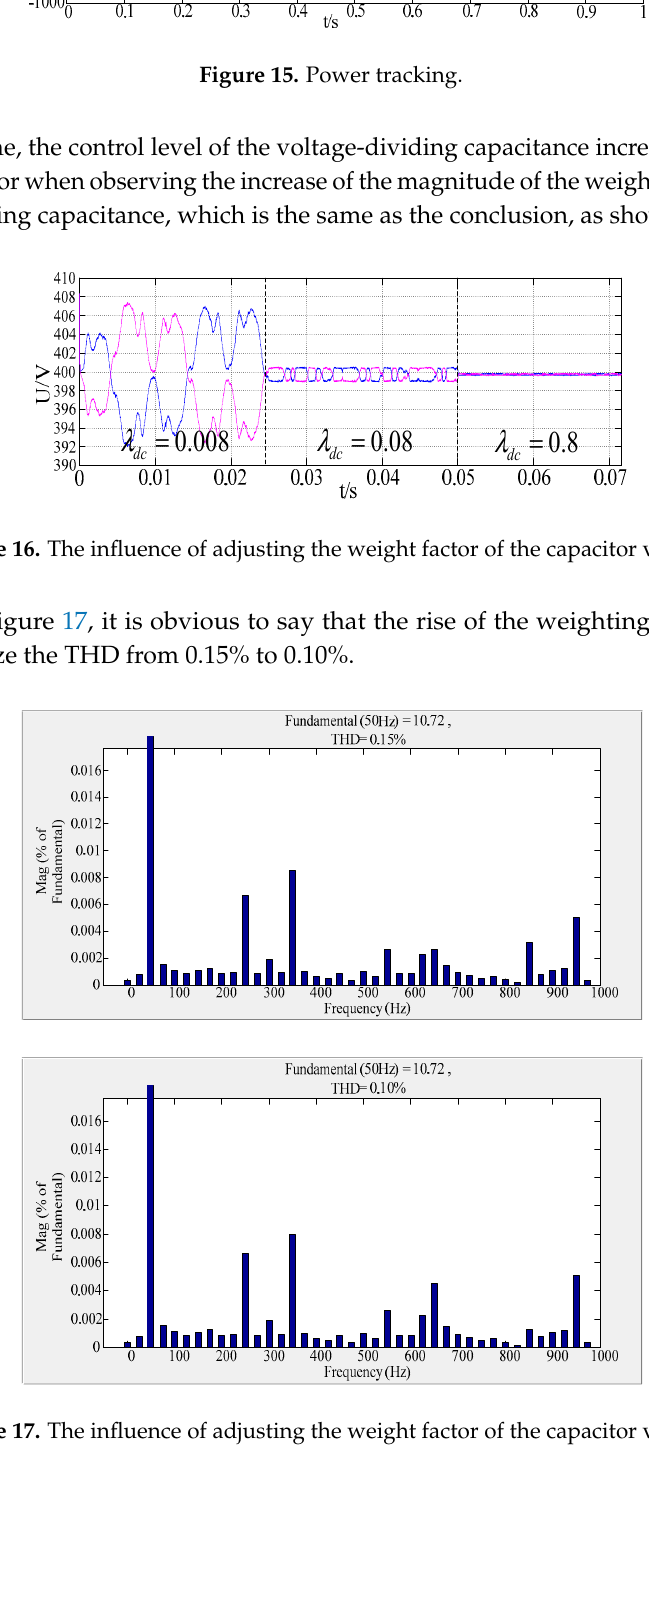
Figure 15. Power tracking.